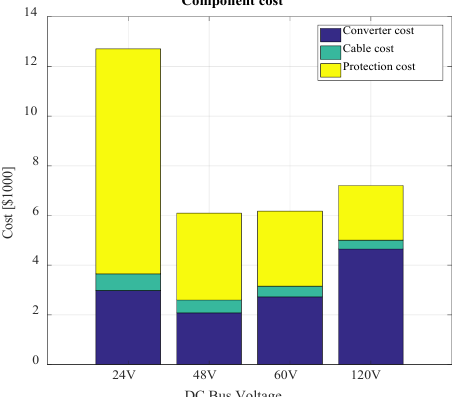
Figure 6. Total component cost at each voltage level.